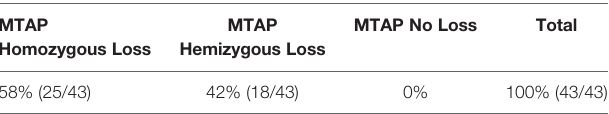
TABLE 5 | Homozygous, hemizygous and no loss of methylthioadenosine phosphorylase (MTAP) detected by droplet digital PCR (ddPCR) in malignant pleural mesothelioma (MPM) samples.